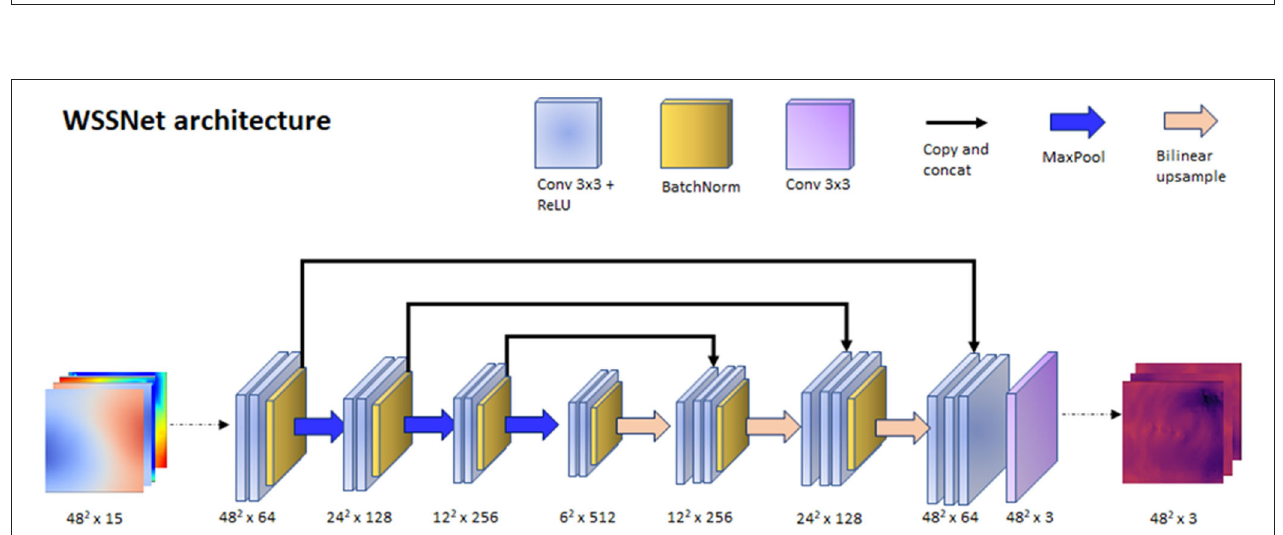
FIGURE 4 | WSSNet architecture. The network is based on U-Net architecture, which receives an input of 15 channels of 48 × 48 patches, consisting of coordinate flatmaps and velocity sheets, and outputs Cartesian wall shear stress vector patches.